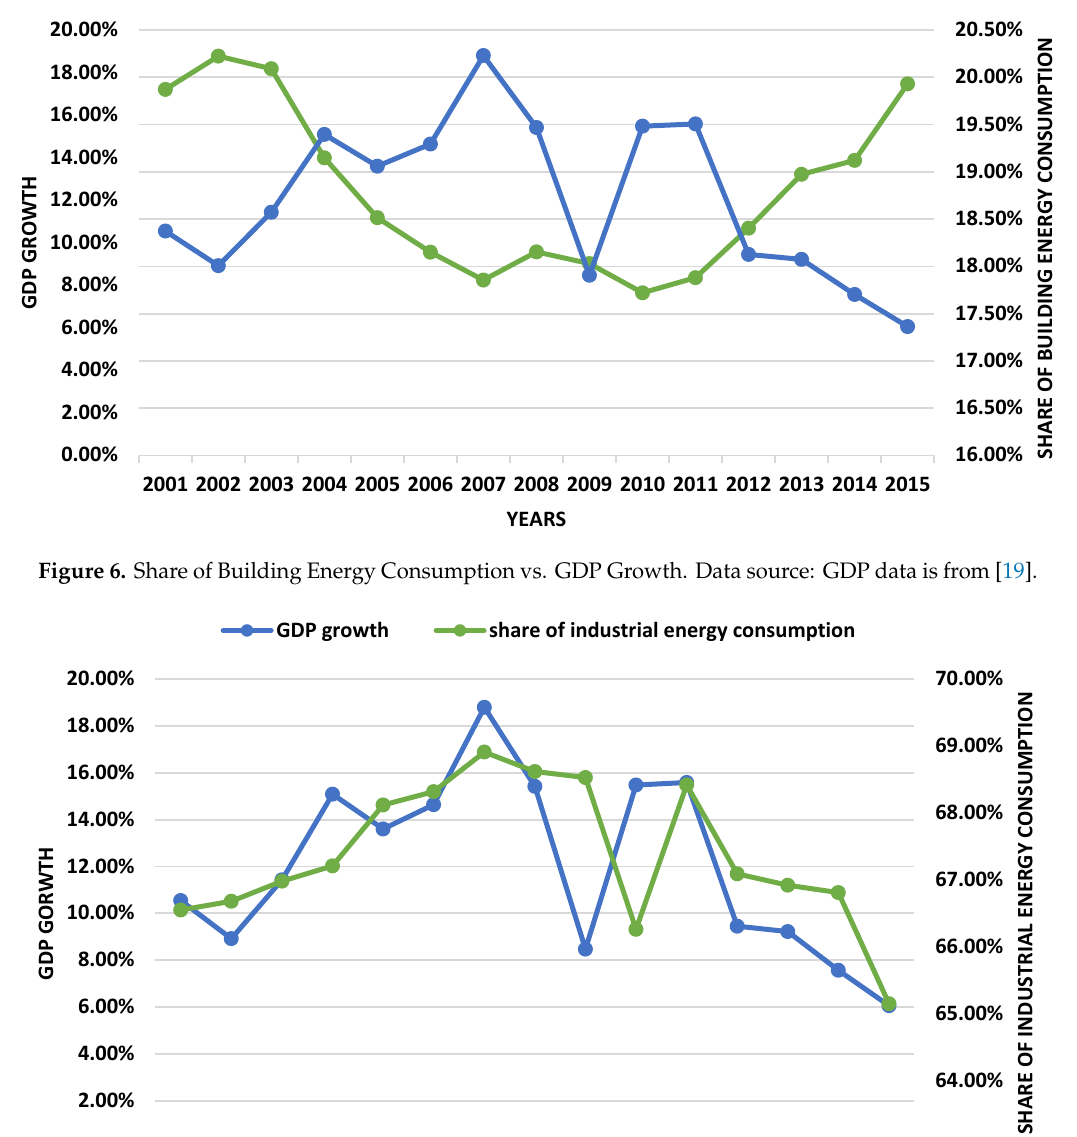
Figure 7. Share of Industrial Energy Consumption vs. GDP Growth.